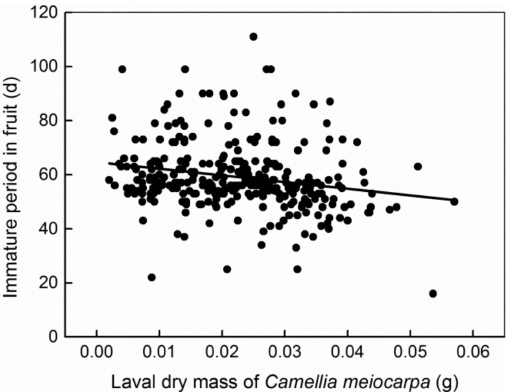
Figure 2. Linear correlation between the immature (eggs and larvae) period (d) in fruit and the larval dry mass (g) of C . meiocarpa .